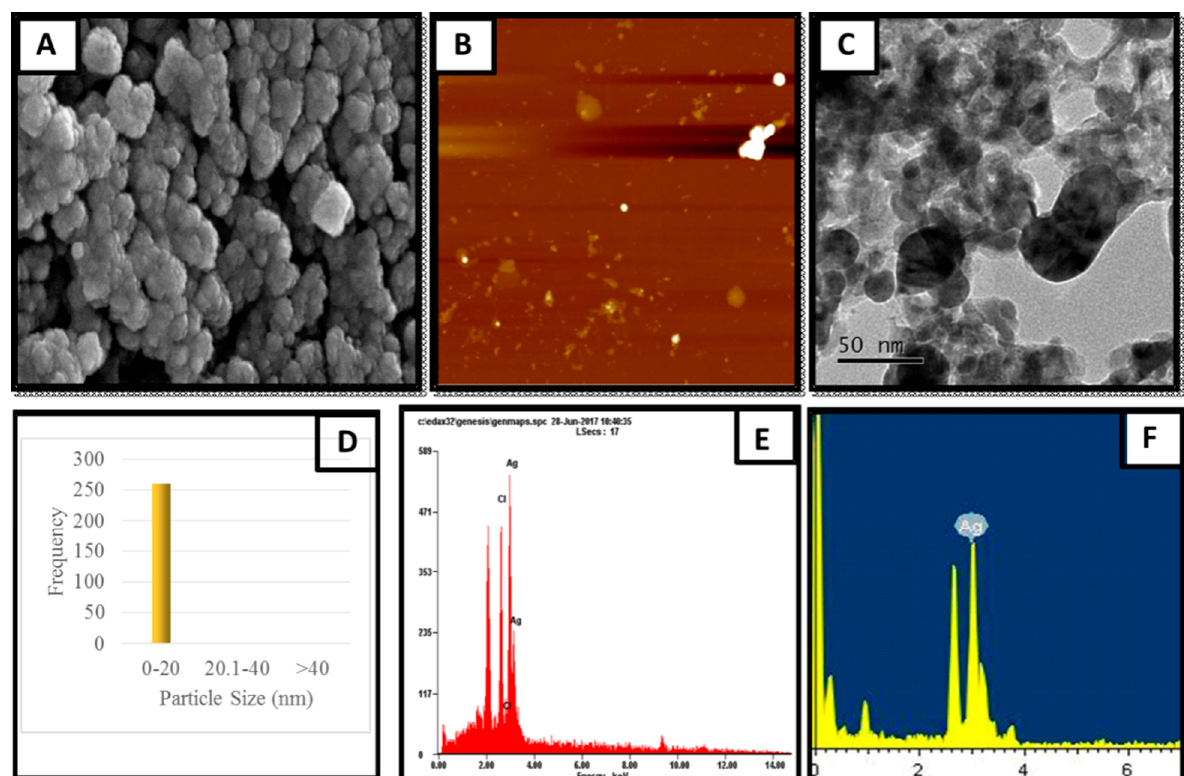
Figure 2. Structural characteristics of produced AgNPs. ( A ) SEM image with the scale of 200 nm; ( B ) spherical AgNPs observed using AFM; ( C ) TEM image with the scale of 50 nm; ( D ) histogram representing AgNP size distribution; ( E ) energy dispersive X-ray spectroscopy analysis with field emission scanning electron microscopy; ( F ) energy dispersive X-ray spectroscopy analysis with TEM.